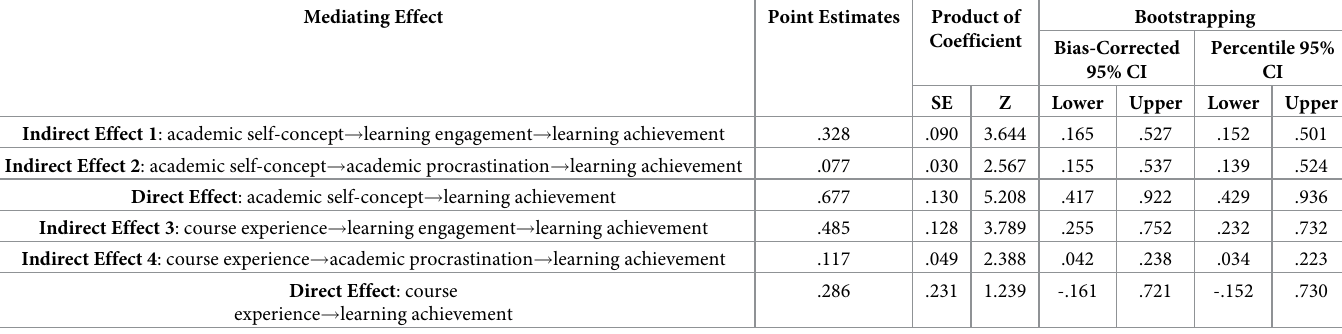
Table 2. Mediating effect test of english learning engagement and english academic